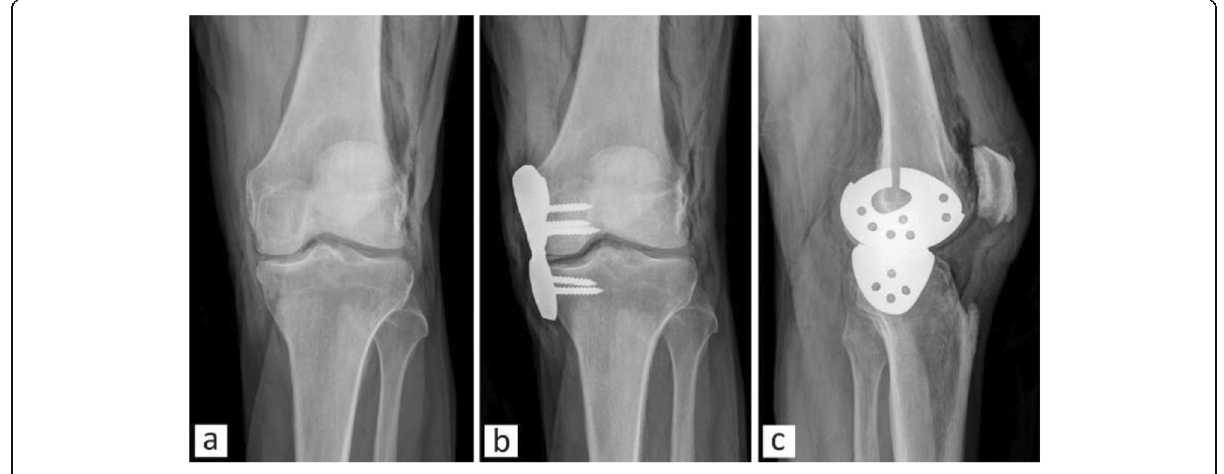
Fig. 11 X-ray of the knee joint: a AP without implant, b AP with implant, c lateral with implant